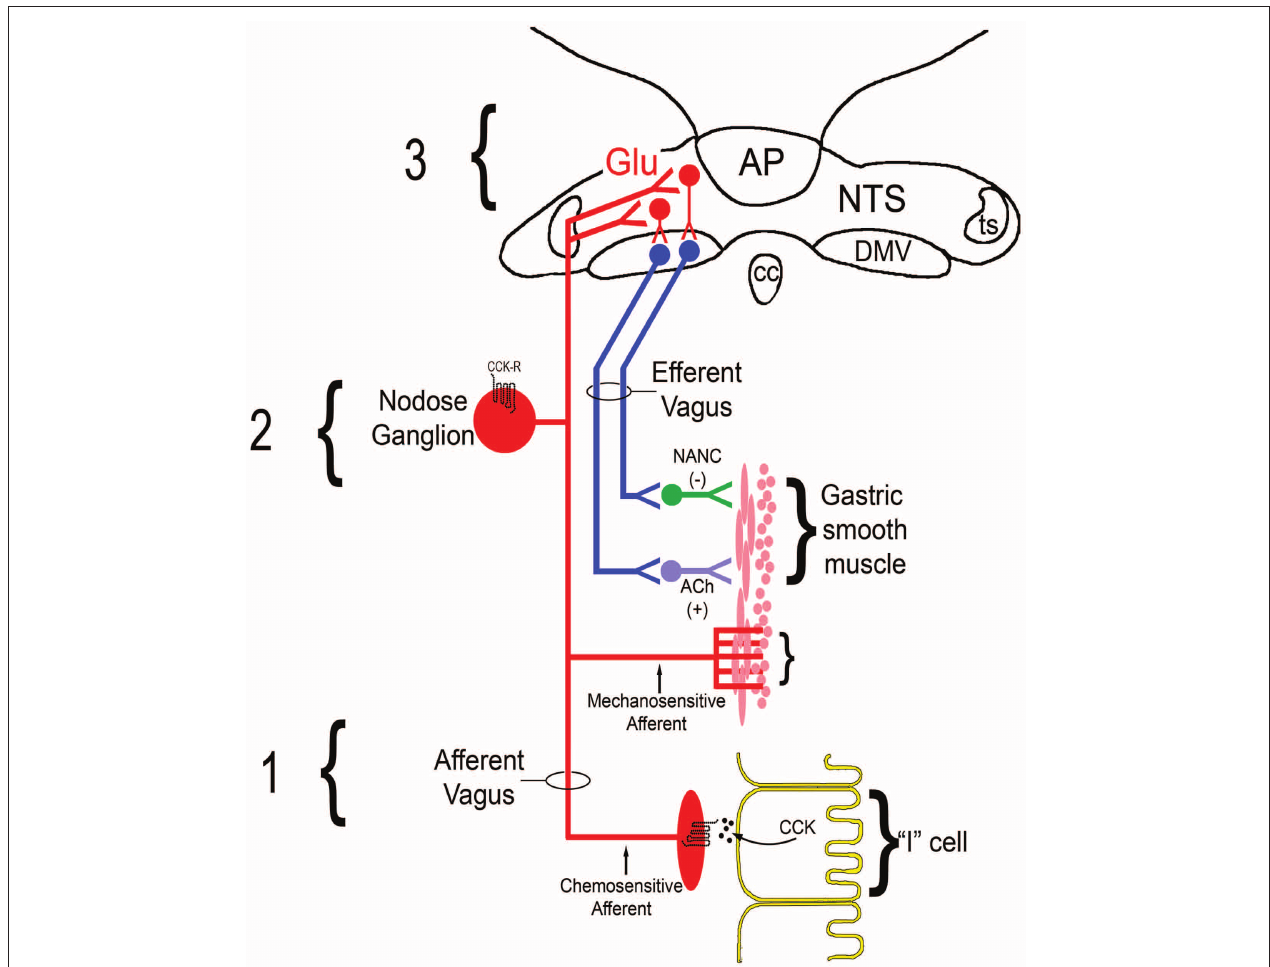
FIGURE 3 | Hypothesized schematic of diminished vagal sensory processing following T3-SCI. (1) Impairments within GI enterocytes (for example CCK-secreting “I” cells) leading to a reduction in the synthesis or release of feeding-related GI peptides such as CCK may reflect a failure in transduction mechanisms at the level of the primary afferent. (2) Downregulation of appropriate receptors, which most likely occurs at multiple levels of vagal afferent neurons residing within the nodose ganglion [reviewed in Dockray and Burdyga (2011)], to feeding-related GI peptides diminishes glutamatergic signaling in the NTS-DMV leading to failed signaling